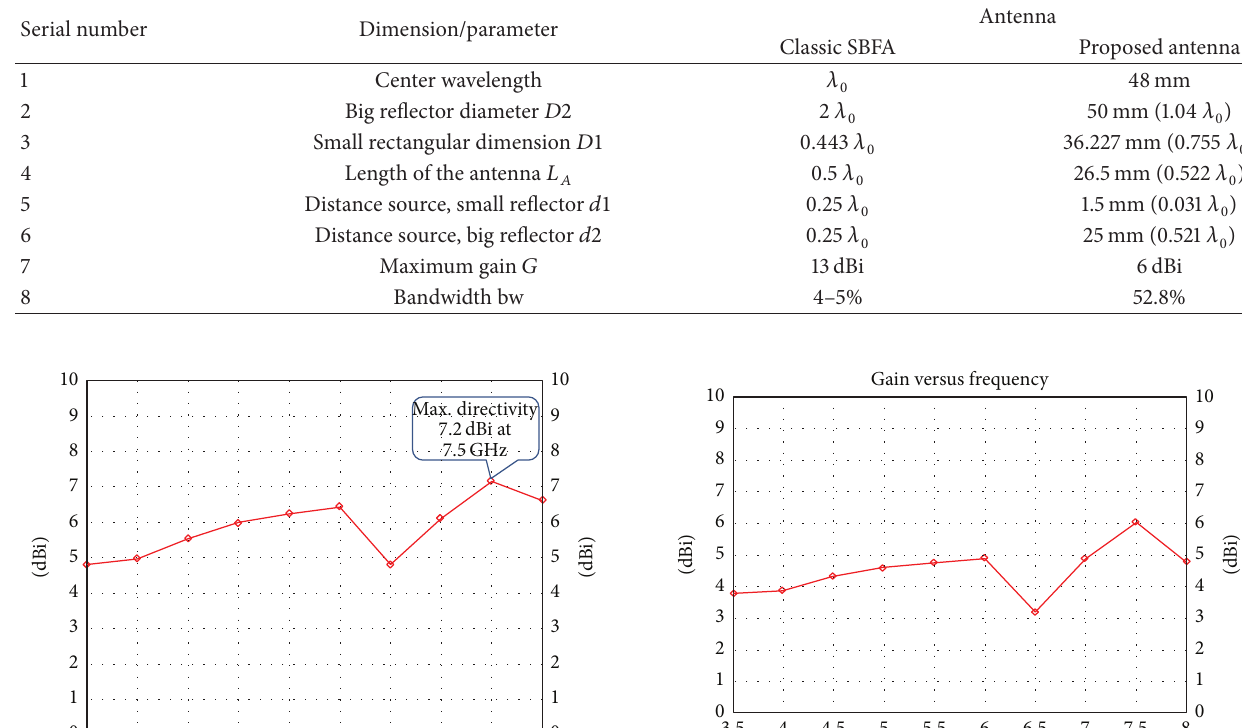
Table 6: Comparison between the classic SBFA and the proposed antenna.